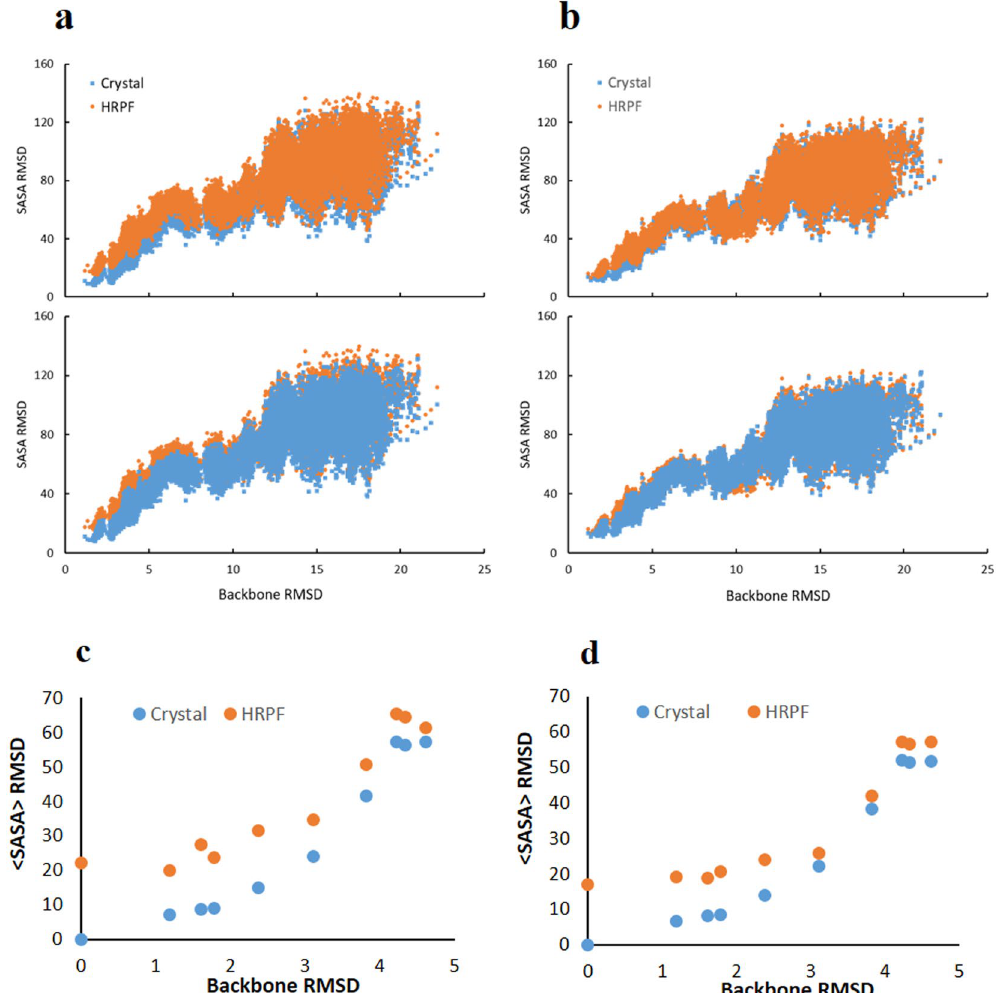
Figure 5. Evaluation of HR-HRPF derived < SASA > for assessing the quality of protein structural models. ( a ) SASA RMSD calculated on structure obtained from an unfolding MD simulation of lysozyme using crystallographic < SASA > and HR-HRPF derived < SASA > based on free amino acids normalization approach using only highly reactive amino acids as reference; ( b ) SASA RMSD calculated on structure obtained from an unfolding MD simulation of lysozyme using crystallographic < SASA > and HR-HRPF derived < SASA > based on the ratio of reactivity (native: denatured) approach as reference. Top and bottom panels of ( a and b) show the same data, with different data series in front ( c ) SASA RMSD obtained from homology modeling analysis of lysozyme using crystallographic < SASA > and HR-HRPF derived < SASA > based on free amino acids normalization approach as reference. ( d ) SASA RMSD obtained from homology modeling analysis of lysozyme using crystallographic < SASA > and HR-HRPF derived < SASA > based on the ratio of reactivity (native: denatured) approach as